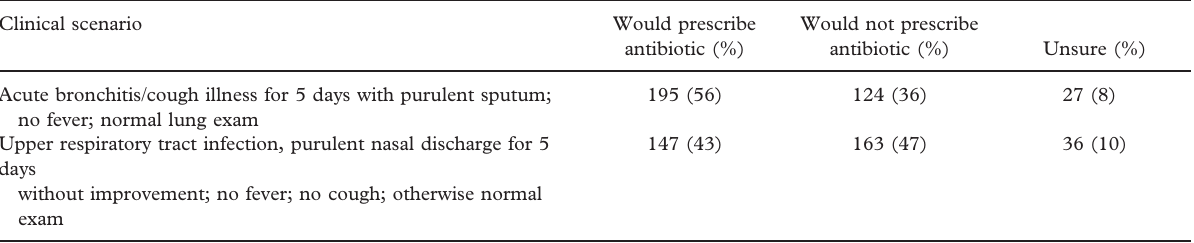
Table II. Reported practices among OB/GYNs regarding treatment of URI in non-pregnant patients *( n